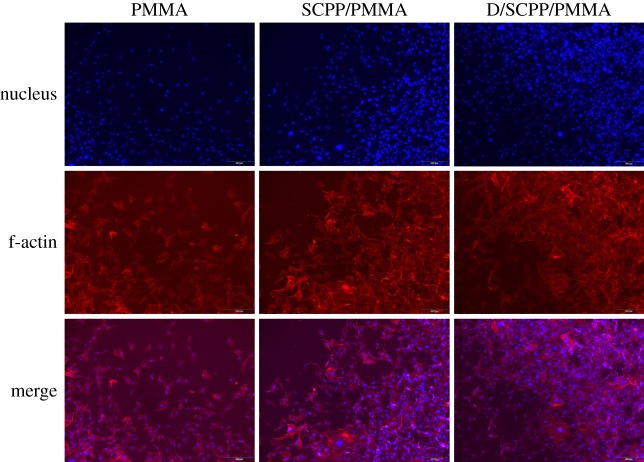
The confocal microscopy images of adhesion and growth of MG63 cells on PMMA composite bone cement.